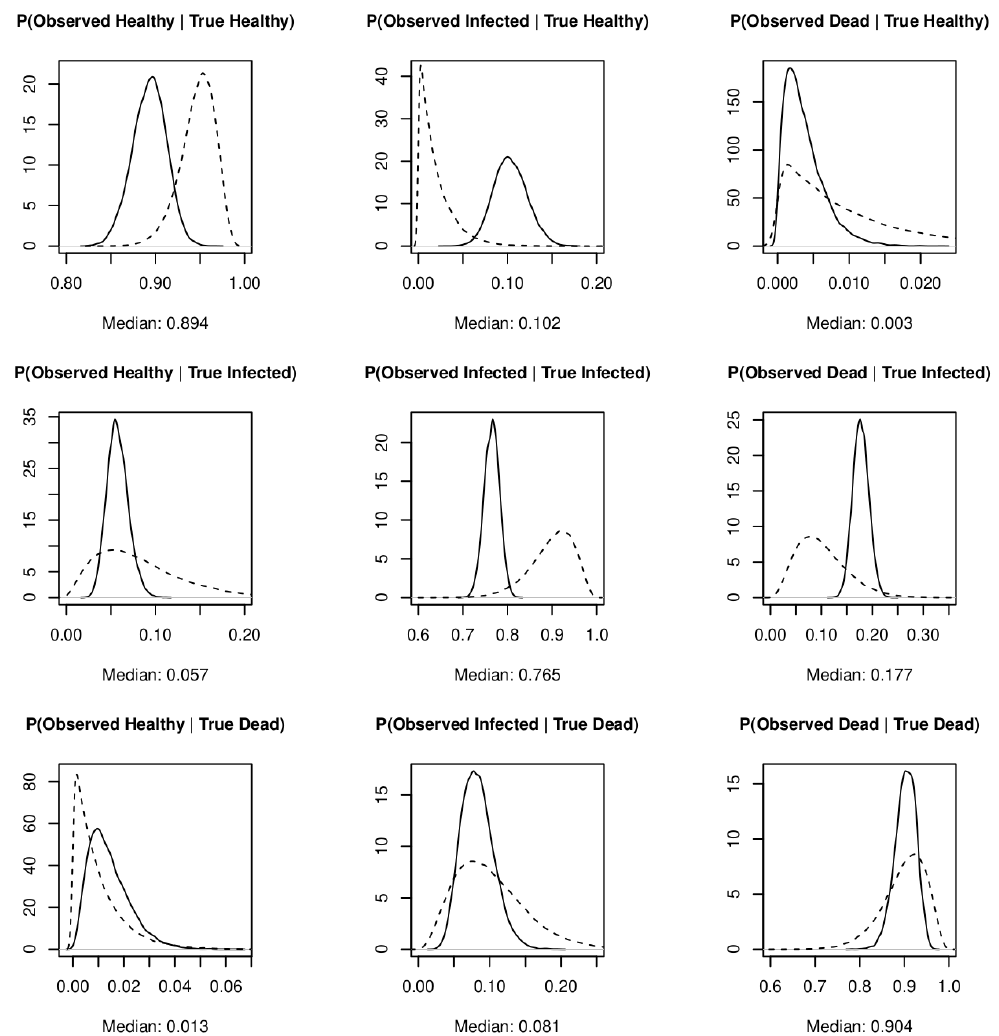
Figure 7. Posterior distributions for observed infection status probabilities conditional on the latent infection status. Dashed lines show the prior distributions.